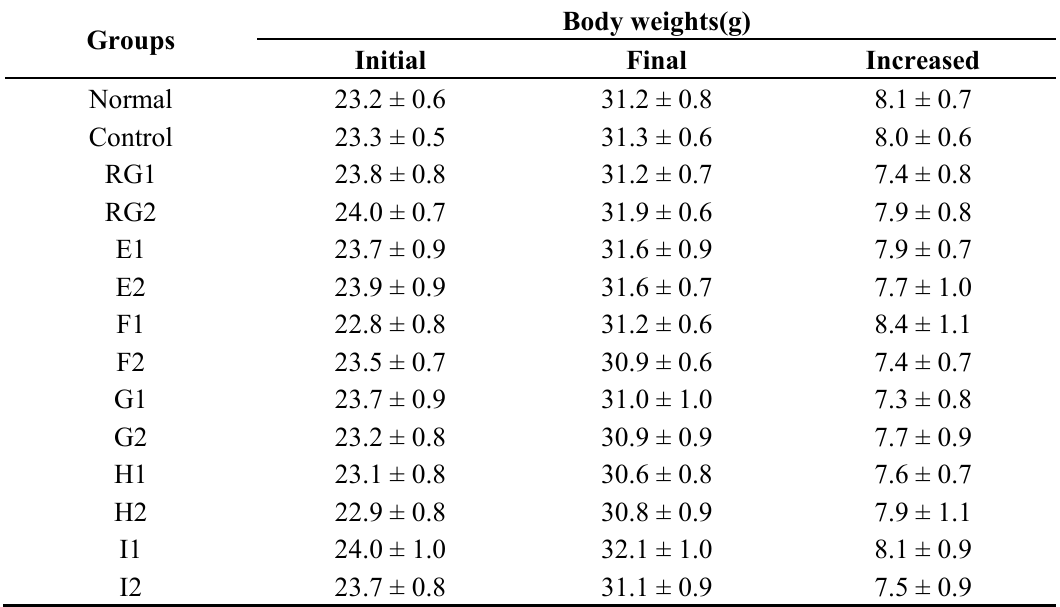
on mice body weights. 1